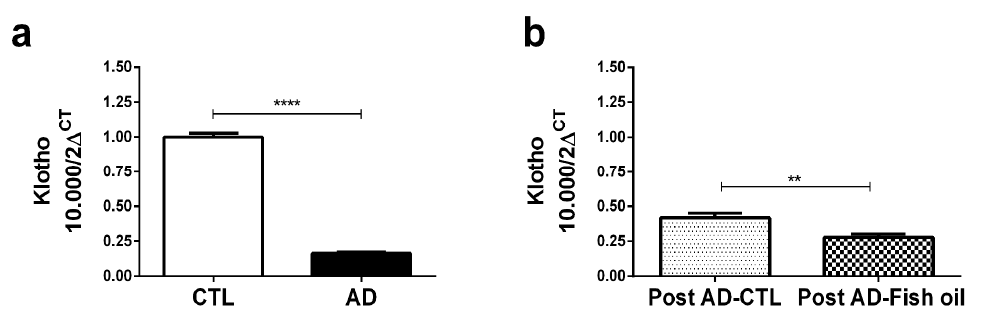
Figure 3. mRNA Klotho by PCR: ( a )CTL/AD and ( b ) Post AD-CTL and Post AD-Fish oil mice (** p < 0.01, **** p < 0.0001).